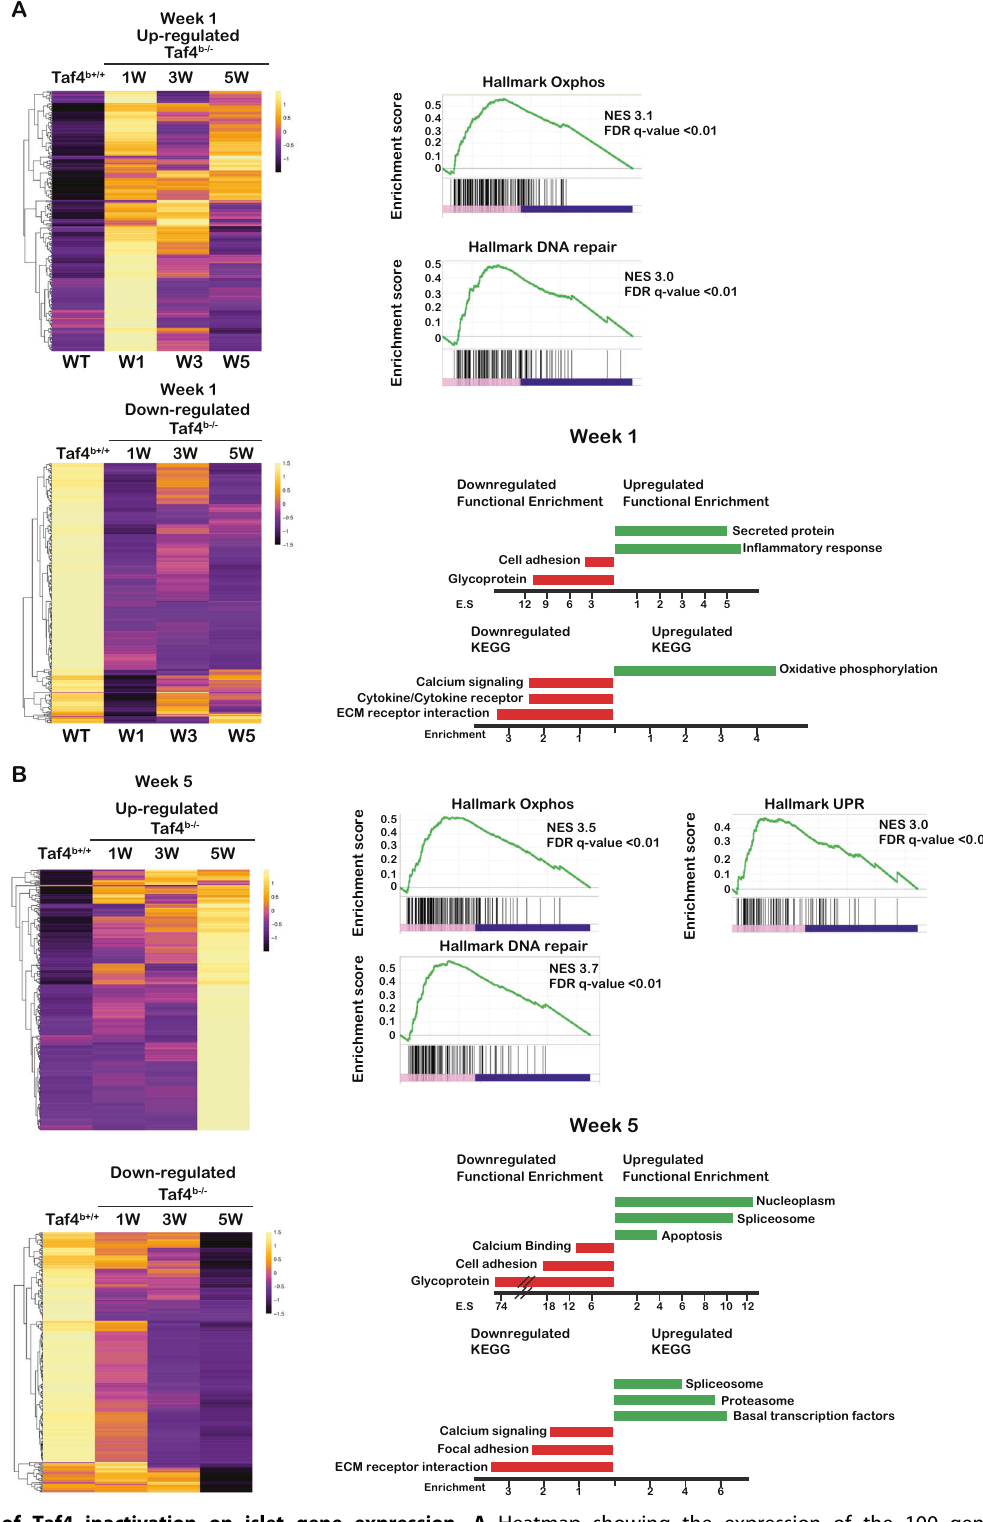
Fig. 3 Effects of Taf4 inactivation on islet gene expression. A Heatmap showing the expression of the 100 genes most up and downregulated 1 week after Taf4 inactivation. Right hand panels show the GSEA and ontology analyses of the de-regulated genes. B Heatmap showing the expression of the 100 genes most up and downregulated 5 weeks after Taf4 inactivation. Right hand panels show the GSEA and ontology analyses of the de-regulated